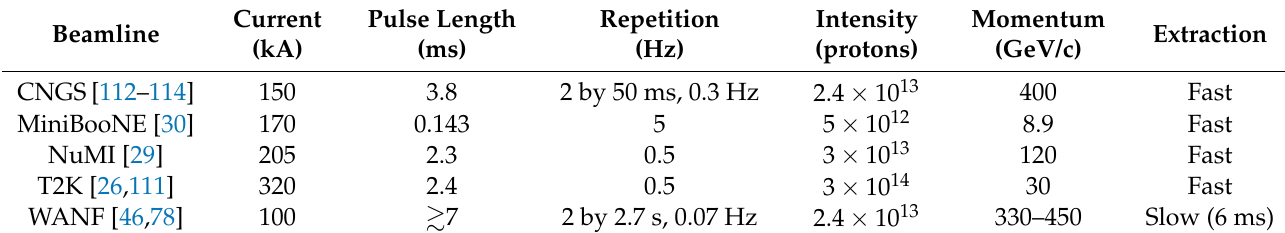
Table 1. Summary of the main horn and extraction parameters for different neutrino beams. The repetition rates of CNGS and WANF consisted in two separate proton pulses, separated by the time interval reported in the table. “Pulse length” is the time duration of the current pulse from the power supply, while “Current“ refers to the peak current value of the pulse.